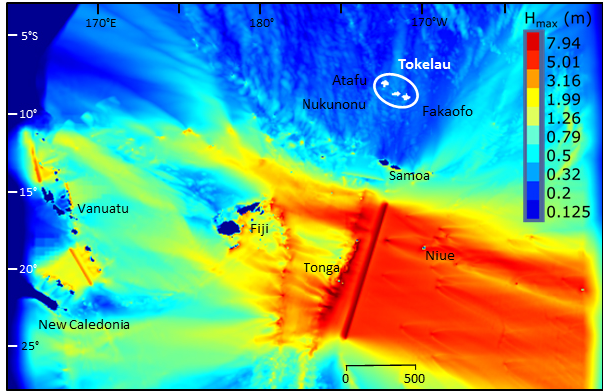
Figure 8. Maximum wave amplitudes (above m.s.l.) for the com- pilation of maximum regional source simulations (the colour scale for H max shows 0.125m in dark blue to 7 + m in red). The atolls of Tokelau are indicated in white and circled (upper